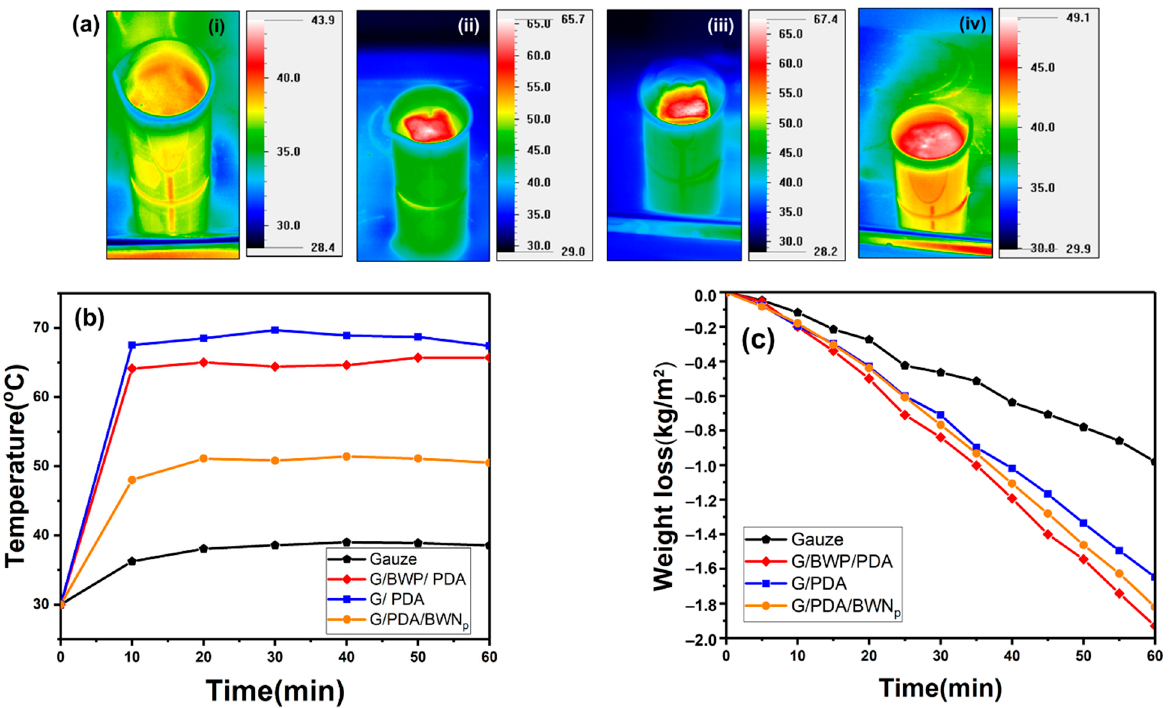
Figure 10. ( a ) Bulk water temperature distribution of (i) gauze (ii) G/BWP/PDA (iii) G/PDA (iv) G/PDA/BWN P , and ( b ) surface temperature profiles over time ( c ) mass loss of water over time by gauze, G/PDA, G/BWP/PDA, G/PDA/BWN P after simulated solar illumination at 1 kW m − 2 (1 sun).